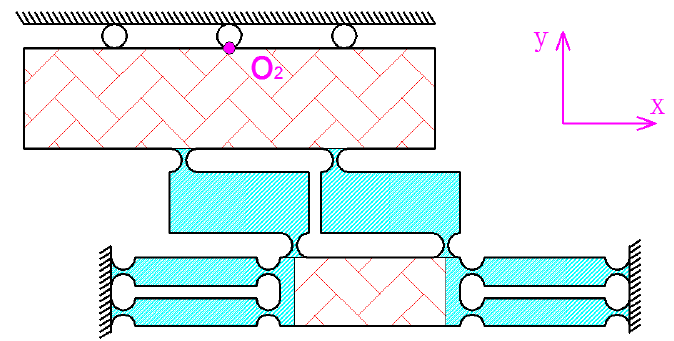
Figure 9. x and y power part.